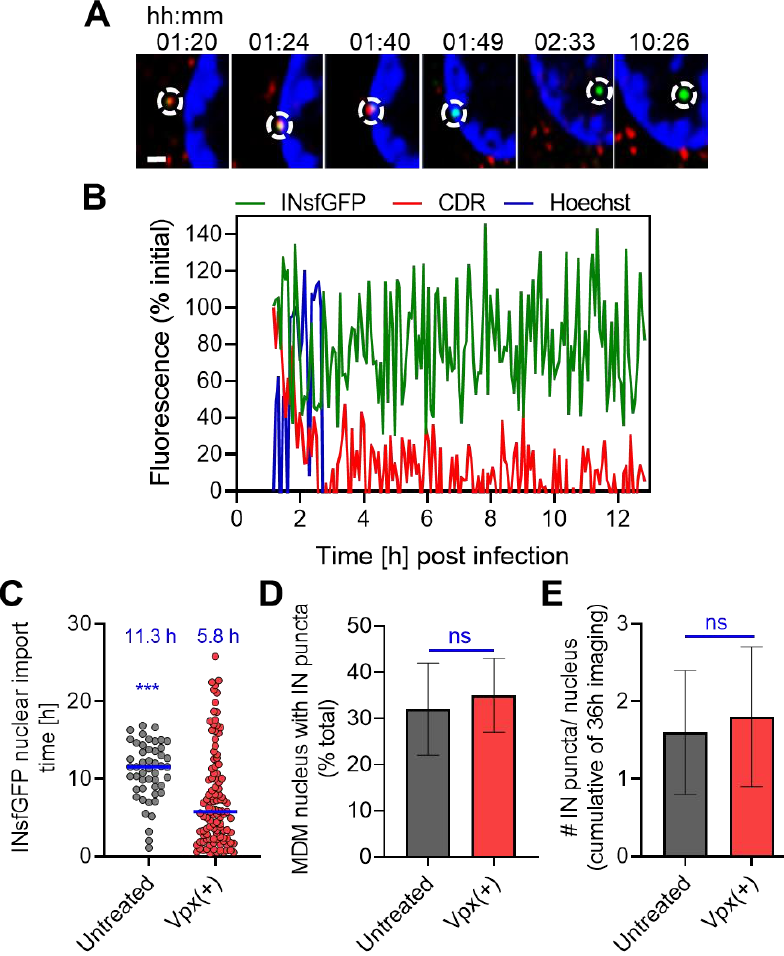
Figure 4. HIV-1 nuclear import is preceded by the loss of CDR / CA marker at the nuclear envelope and is accelerated by Vpx( + ) treatment. Untreated or SIV-VLP Vpx( + )-treated MDMs were infected at MOI 0.5 with VSV-G-pseudotyped HIVeGFP virus fluorescently labeled with INsfGFP and CDR. Single-virus tracking was performed to visualize HIV-1 uncoating and nuclear import from 0 to 40 hpi. ( A , B ) An example of single HIV-1 nuclear import in MDM progressing through a loss of CDR at the nuclear membrane and intranuclear transport of the INsfGFP complex. ( A ) Images and ( B ) single-particle fluorescence intensity traces of HIV-1 uncoating and nuclear import in Vpx( +